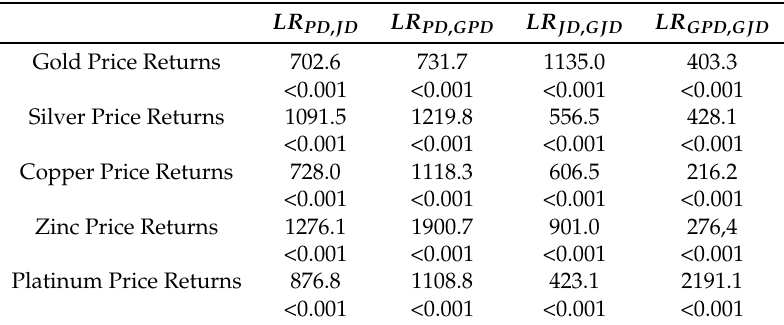
Table 3. Likelihood ratio test